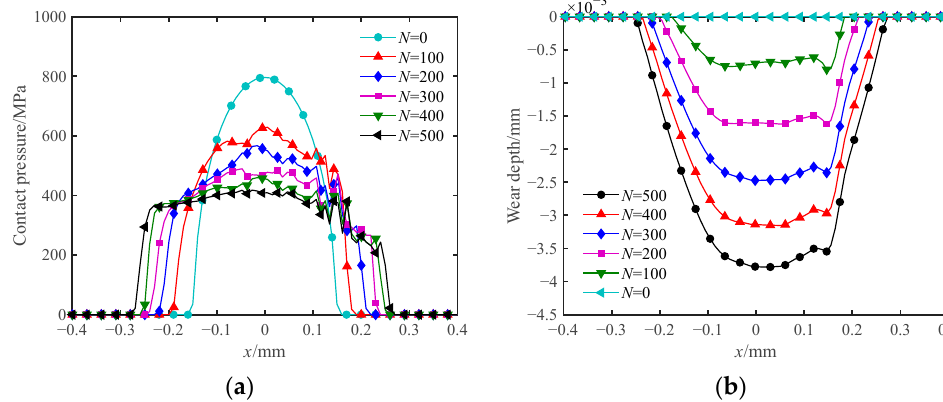
Figure 9. Variation of contact pressure and wear depth with the number of cycles. ( a ) Contact pressure; ( b ) wear depth.